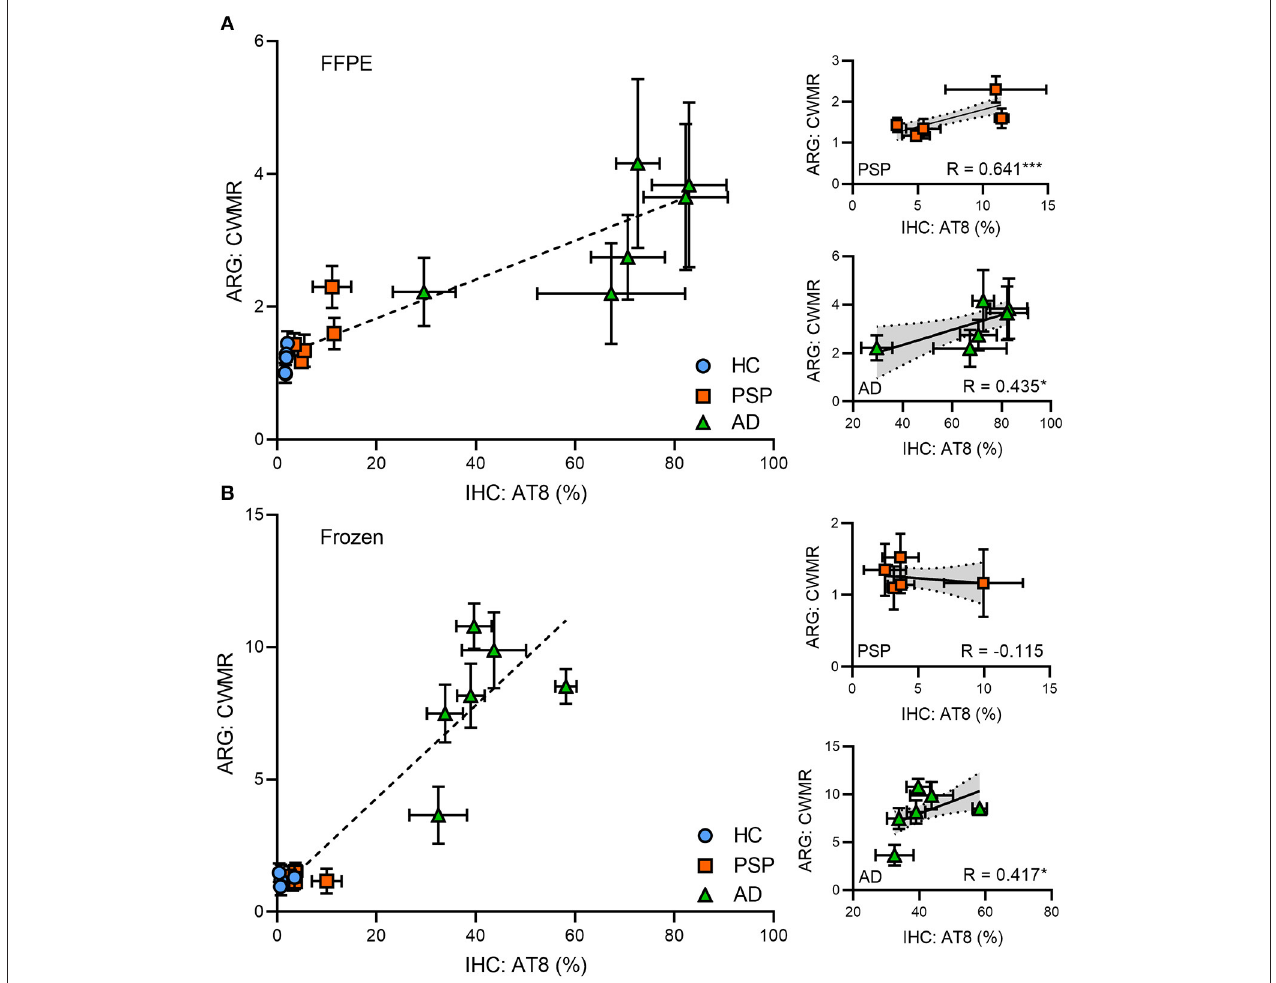
FIGURE 4 | Quantitative correlation of autoradiography and immunohistochemistry for FFPE (A) and frozen (B) tissue for all entities and AD/PSP patients (each symbol represents on patient), respectively. Simple linear regressions are expressed by R -values and regression lines with corresponding 95%-confidence intervals for AD and PSP. AD, Alzheimer’s disease; PSP, progressive supranuclear palsy; HC, healthy control; FFPE, formalin-fixed paraffin-embedded; IHC, immunohistochemistry; ARG, autoradiography; CWMR, cortex to white matter ratio; * p < 0.05, *** p <